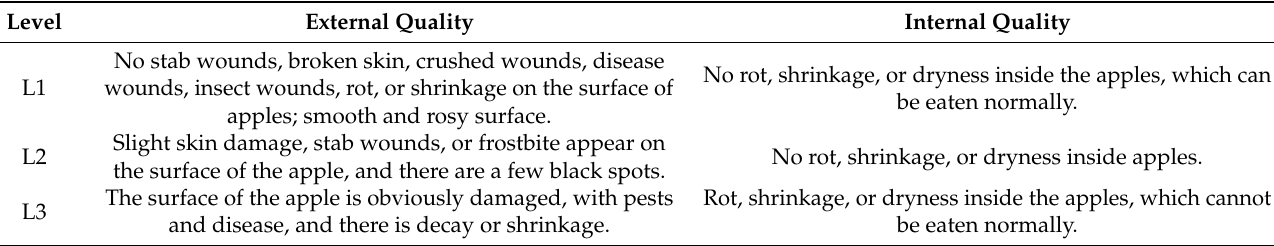
Table 1. Descriptions of the three levels of apple quality: L1, L2, and L3.